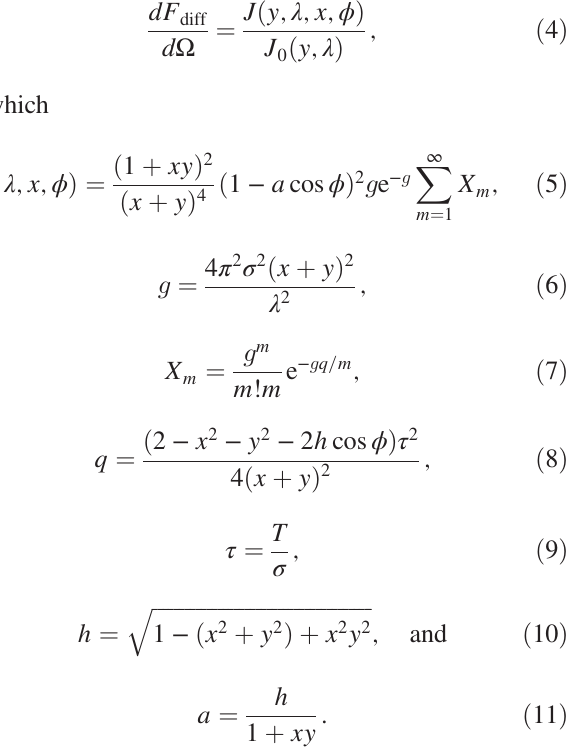
FIG. 3. In-plane diffuse scattering distributions for 30 eV photons. The full diffuse scattering expression [Eq. (4)] has been used to calculate these curves.